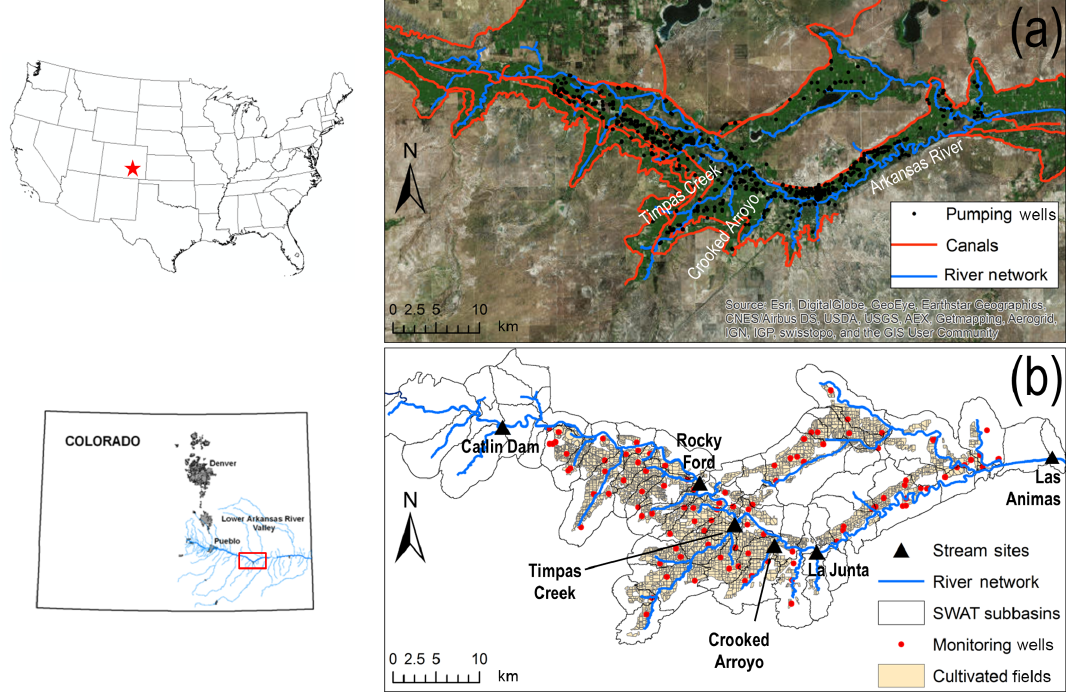
Figure 3. Map of the study region within the Lower Arkansas River Valley of Colorado, showing (a) the Arkansas River and tributaries, irrigation canals, and pumping wells, and (b) cultivated fields, monitoring wells where groundwater is sampled for salt ions, sampling sites where surface water is sampled for salt ions, and SWAT